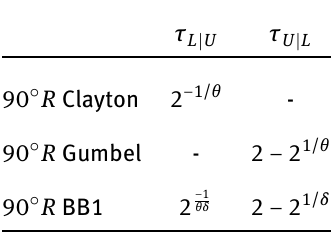
θ and δ are the copula param- eters from the original